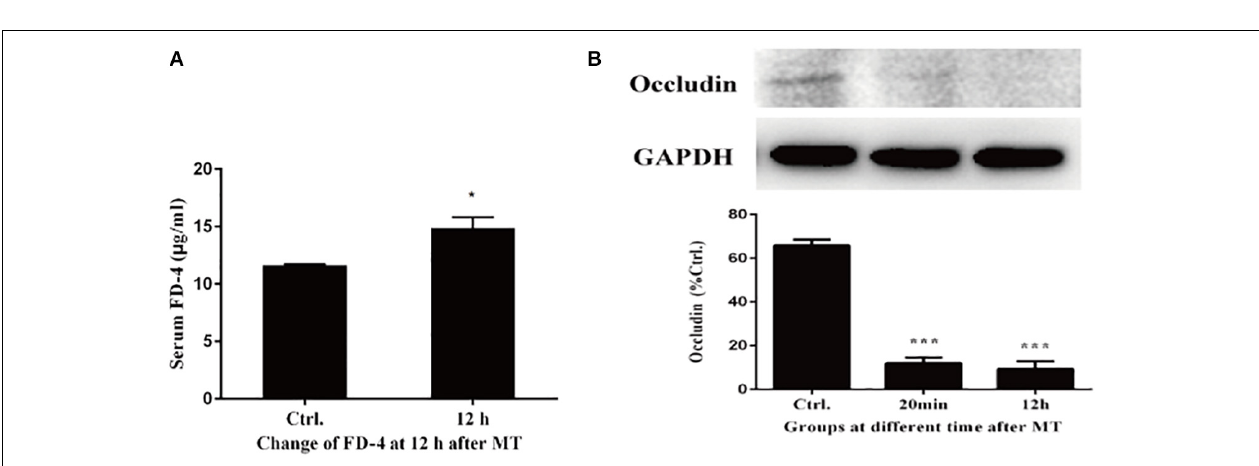
FIGURE 10 | Changes of mucosal permeability in intestinal mucosa. (A) Serum concentration of FD-4 in SD rats at 12 h after MT (* P < 0.05 vs. the control). (B) The expression of Occludin at 20 min and 12 h after MT (*** P < 0.001 vs. the control).